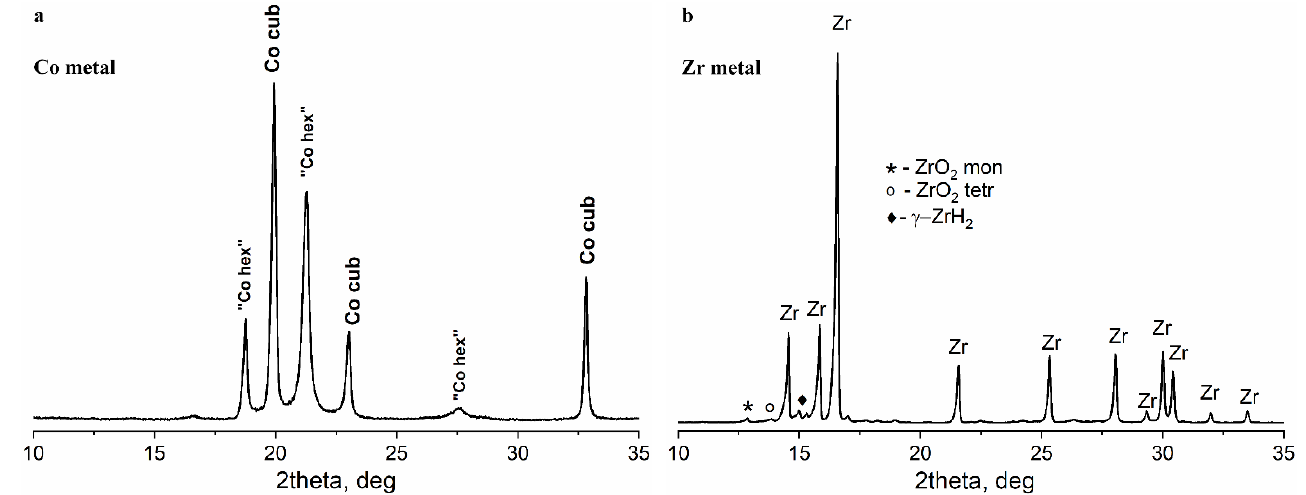
Figure 1. ( a ) X-ray diffraction pattern of the initial metallic cobalt powder; ( b ) X-ray diffraction pattern of the initial metal zirconium powder. The diffraction lines corresponding to minor phases in the sample are marked with symbols.